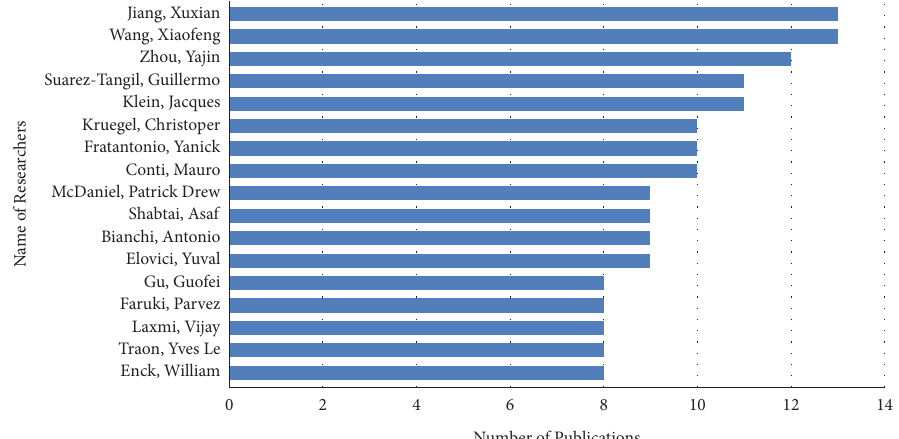
Figure 7: Top researchers in Android security research.